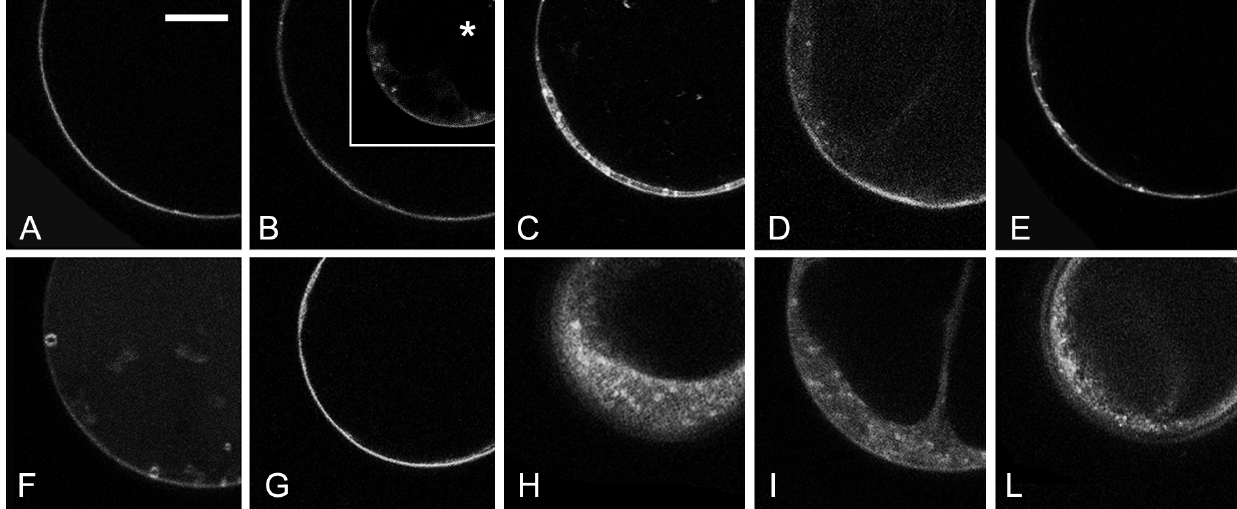
Figure 3. FM4-64 internalization in tomato hypocotyl protoplasts. ( A – E ) Images of protoplasts within the first 20 min of staining. ( A ) In control conditions labelling remained essentially limited to the PM in all large cells; ( B ) Effect of BFA treatment appeared to reduce FM4-64 internalization in large cells even if in small cells BFA bodies rapidly appeared (inset * ); ( C ) Effect of treatment of protoplasts with 5 μ M Auxin; ( D ) Effect of treatment with 50 μ M ACh; and ( E ) Effect of combined chemicals; ( F – L ) Images of protoplast after 80 min of staining. ( F ) Control protoplast with defined late endosomes; ( G ) BFA treated cell with no internalization of the dye; ( H ) Protoplast treated with Auxin; ( I ) Protoplast treated with ACh; and ( L ) Protoplast treated with combined chemicals. Scale bar: 10 μ